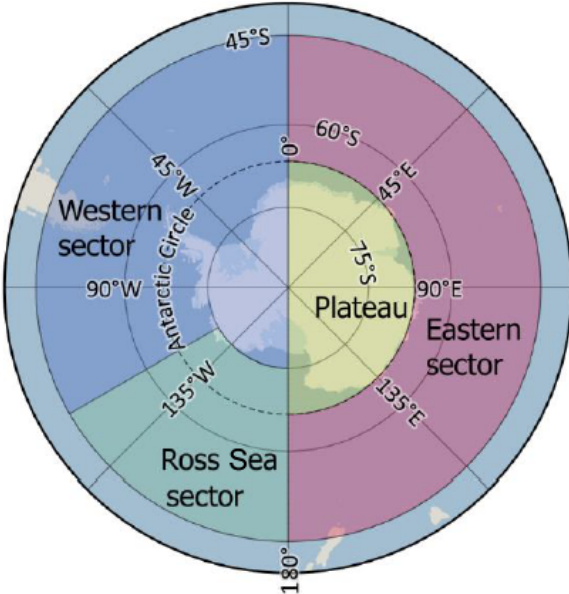
Figure 2. Representation of the sectors used to classify the last point of the simulated back trajectories by HYSPLIT over the pe- riod 1998–2014, defined as follows: (i) the eastern sector (0–66 ◦ S, 0–180 ◦ E), (ii) the plateau (66–90 ◦ S, 0–180 ◦ E), (iii) the Ross Sea sector (0–75 ◦ S, 180–240 ◦ E), and finally (iv) the western sector (0– 75 ◦ S, 180–240 ◦ E) and (50–90 ◦ S, 240–360 ◦